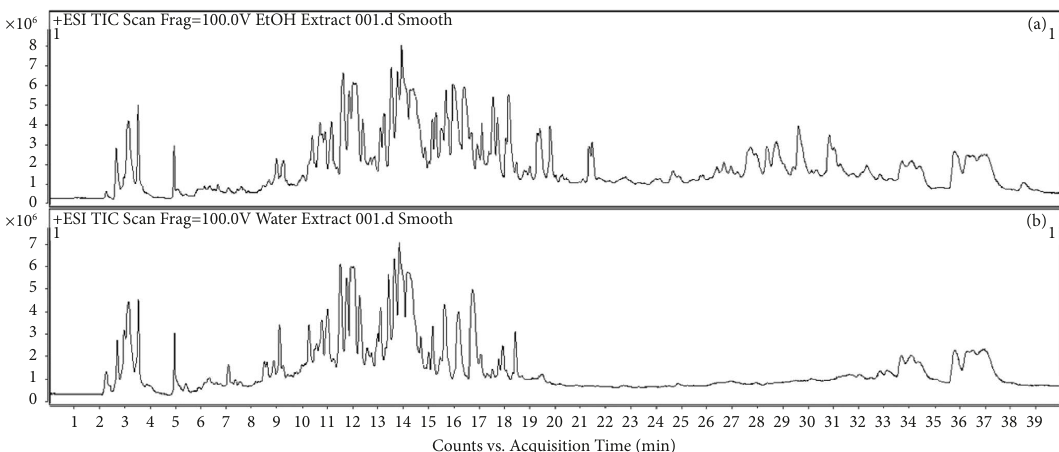
Figure 2: Total ion chromatogram of the ethanolic (a) and water (b) extracts of C. spectabilis fower. Te blue arrow refers to the region in which the extracts show diferent TIC